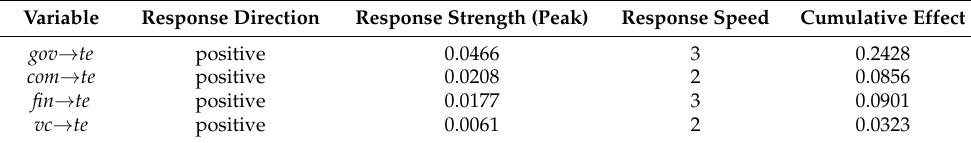
Table 4. Impulse response results of GTIE faced with the shock of technology and